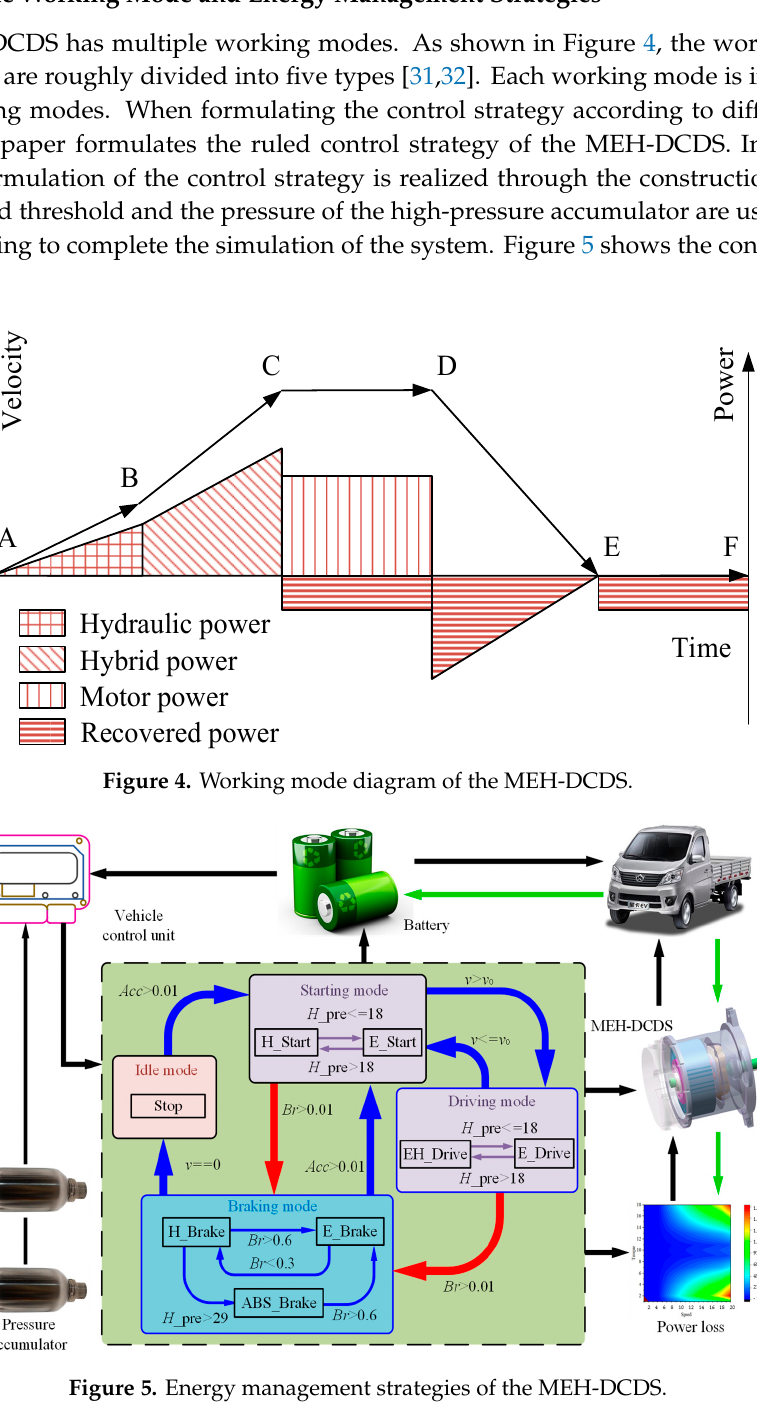
Figure 5. Energy management strategies of the MEH-DCDS. (1) Starting mode: As shown in section AB, the starting torque of the vehicle is greater during starting. The required peak torque makes the battery pack in a high current discharge state, which has a greater effect on the battery SOC. Therefore, when the vehicle begins to accelerate, only the hydraulic system drives the vehicle. When the pressure of the high-pressure accumulator in the hydraulic system is greater than the pressure of the low-pressure accumulator, the secondary element works in the motor state. All the solenoid valve switches are turned on. At this time, the hydraulic oil in the high-pressure accumulator flows to the low- pressure accumulator. The oil drives the hydraulic motor to rotate and converts the hydraulic energy stored in the hydraulic accumulator into mechanical energy. When the pressure is lower